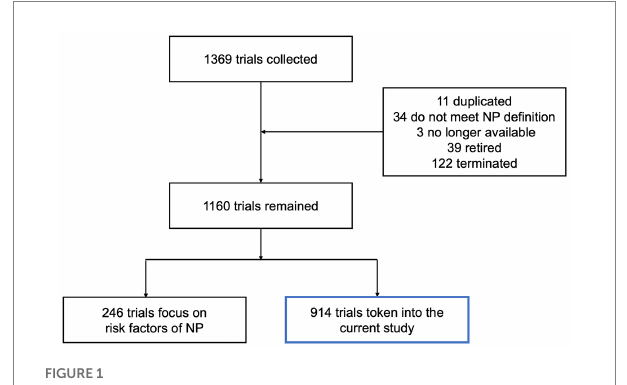
FIGURE 1 Flow chart of the current study.